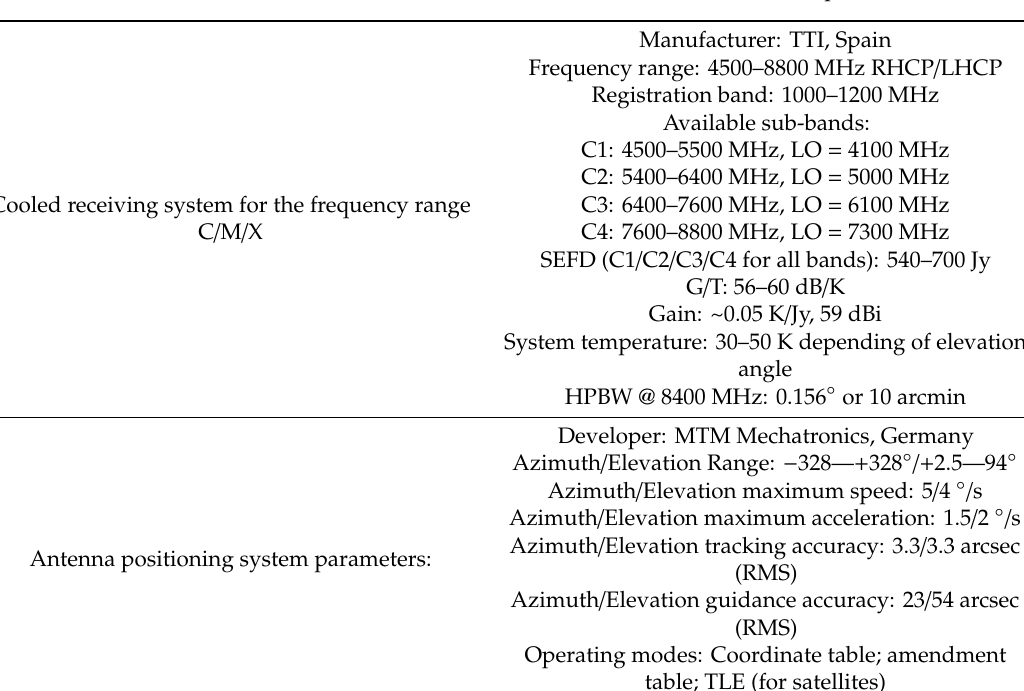
Table 1. Technical information about the 16-m VIRAC radio